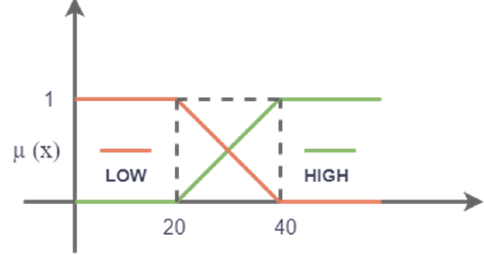
Fig. 4 Degree of likeliness of periodontal abscess